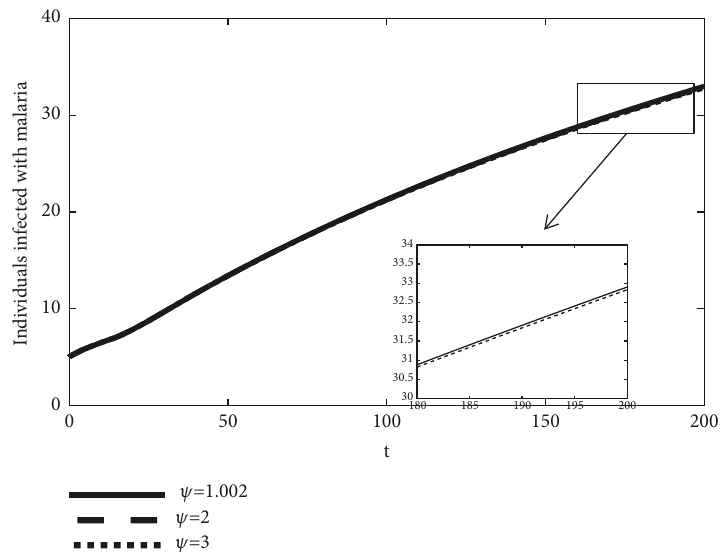
Figure 4: Individuals infected with malaria at 𝛼(𝑡) = 0.8 with 𝜓 = 1.002 (solid line), 𝜓 = 2 (dashed line), and 𝜓 = 3 (dotted line). Parameters values are in Table 1 with 𝛽 ℎ = 0.05